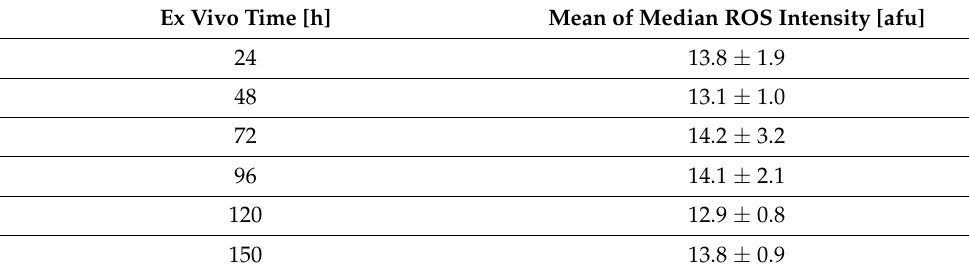
Table 2. Progress of median ROS intensity along the ex vivo time.